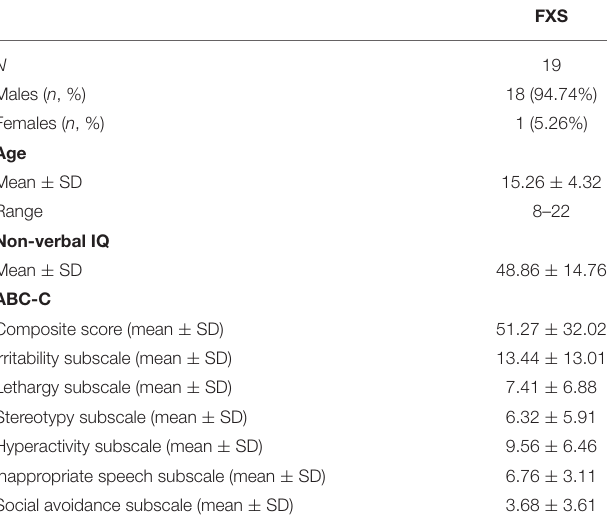
TABLE 3 | Demographics of the “replication study